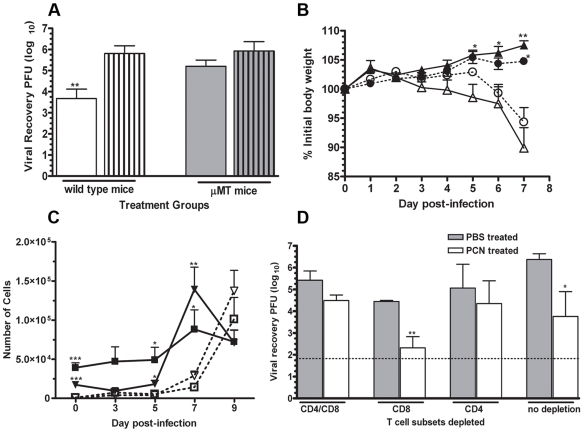
PCN-enhanced resolution of a PR8 influenza virus infection is antibody and CD4+ T cell dependent.A). Viral burden in lungs of PCN-treated (clear bars) wild type mice were significantly less than in the PBS-treated (clear bar with lines) wild type mice at day 7 post-infection whereas no differences in viral burdens in the lungs of the PCN-treated (shaded bars) and PBS-treated (shaded bars with lines) μMT mice were detected at this time; **, P<0.01 relative to PBS–treated control mice; limit of assay detection is 1.82 log10. B). Equivalent levels of body weight loss were detected in the PBS-treated wild type (Δ) and μMT (○) whereas PCN-treated wild type (▴) and μMT (•) both gained equivalent amounts of body weight during the week following influenza infection; *, P<0.05; **, P<0.001 relative to their respective PBS-treated control. C). Recruitment of CD8 (triangle symbols) and CD4 (square symbols) T cells occurs sooner in PCN-treated mice (filled symbols) relative to the PBS-treated (clear symbols) control mice following influenza virus infection; *, P<0.05; **, P<0.01; ***, P<0.001. D). Viral recovery in PBS-treated (shaded bars) and PCN-treated (clear bars) wild type mice depleted of CD8 and/or CD4 T cells at 48 hours before and 4 days after influenza infection; *, P<0.05; **, P<0.01 relative to PBS-treated control; dotted line at 1.82 log10 is limit of assay detection.